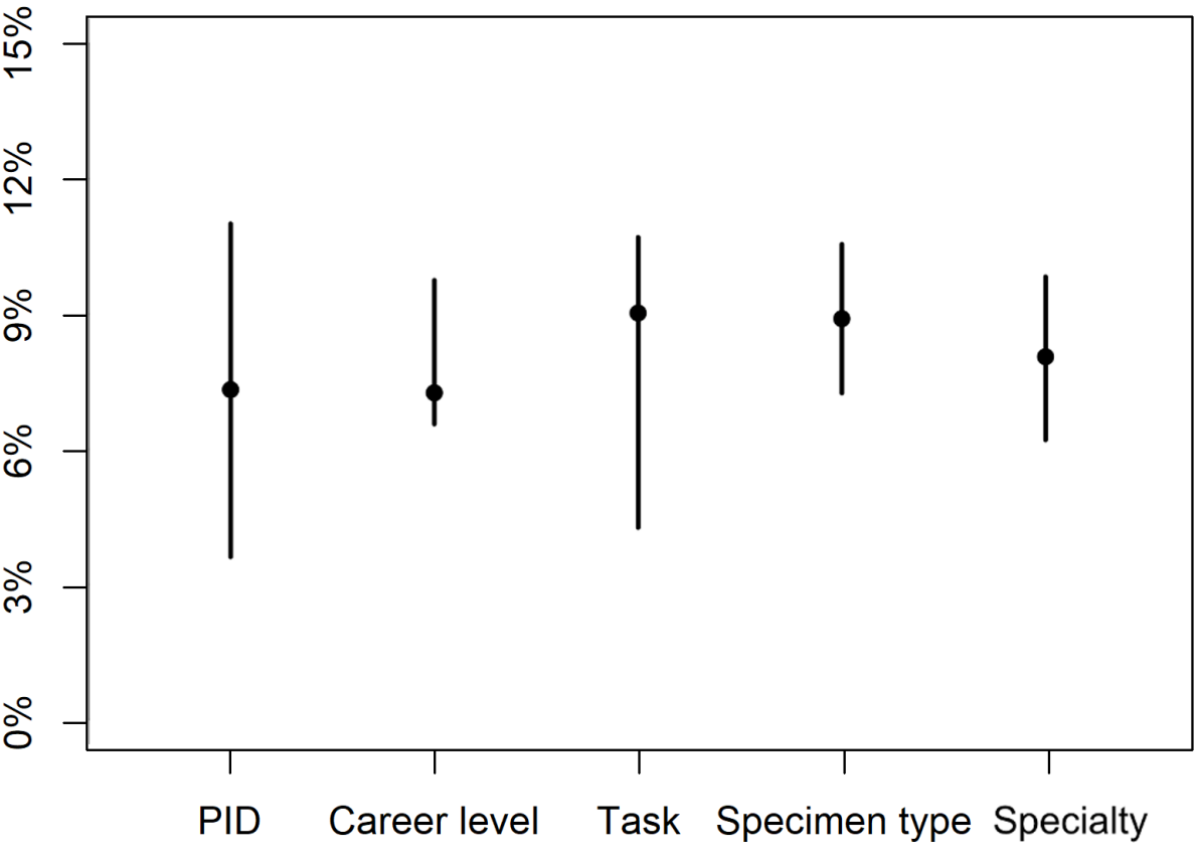
Figure 1. Error rates among different categories. This dot-bar plot depicts the median (IQR) values of error rates among different categories. The error rates showed the widest IQR among individual pathologists (PID), whereas the least IQR was noted for the career level and the specimen type (biopsy vs